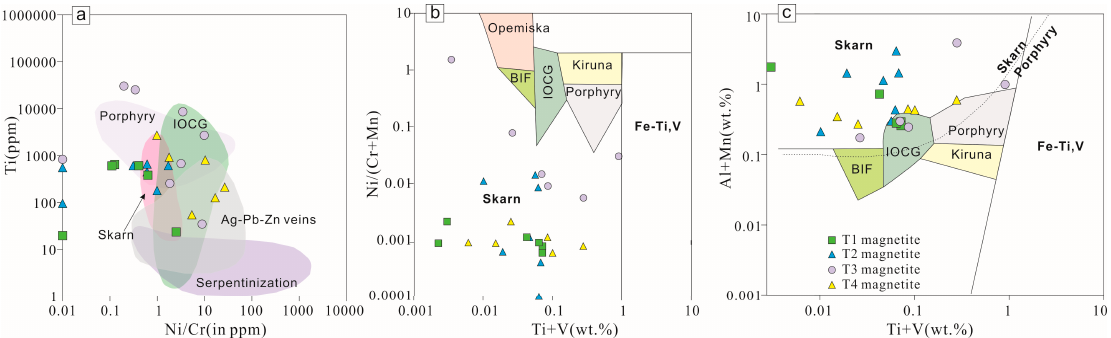
Figure 11. Magnetite discrimination diagrams ( a ) Ti vs. Ni/Cr (after Reference [30]); ( b ) Ni/(Cr + Mn) vs. (Ti + V) (after Reference [28]); ( c ) (Ti + V) vs. (Al + Mn) (after Reference [28]).